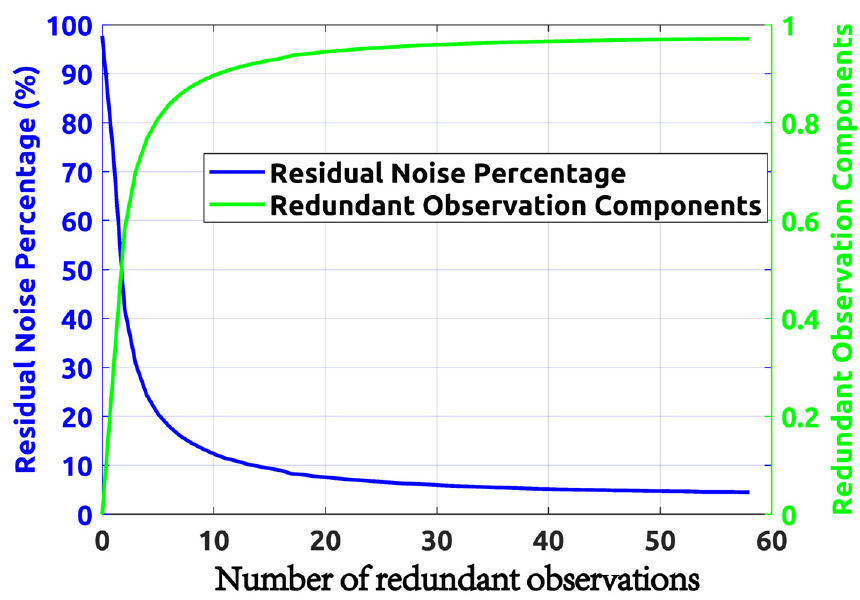
Figure 4. Relationship between the residual noise percentage and the number of redundant observations. The temporal coherence of least squares residual was proposed to measure the quality of the phase unwrapping [41]. The accuracy of the estimated parameters is not only affected by residual error, but also by the SB interferograms. Inspired by geodetic network adjust- ment, we assessed the accuracy of the estimated parameters using the variance-covariance matrix in the Gauss-Markov model. It contains the number of redundant interferograms, the residual error, and the SB interferograms network structure. The variance-covariance matrix was used to describe the accuracy of geodetic network adjustment. Therefore, it is appropriate to assess the accuracy of sequential ISBAS InSAR-derived deformation parameters. For archived SAR data, the variance-covariance matrix of the deformation time series D is written as Equation (5): X ( 1 )